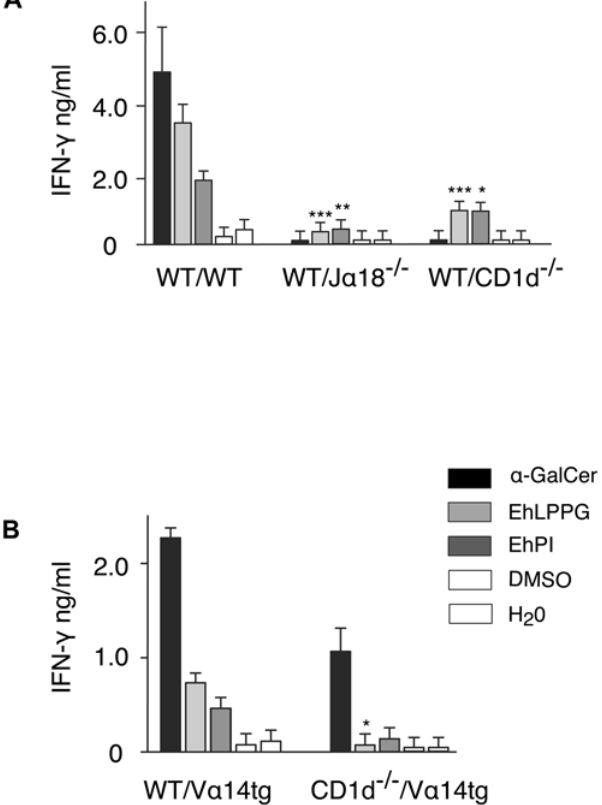
Figure 5. CD1d-restricted NKT cell activation by EhLPPG and EhPI. (A) APC (5x10 4 ) from WT mice were pulsed with either 2 m g of a - GalCer, EhLPPG or EhPI and incubated with 1x10 5 lymphocytes of spleen cell preparations from J a 18 2 / 2 lacking i NKT cells and CD1d 2 / 2 mice lacking i NKT and d NKT cells. IFN- c secretion was measured by ELISA. Difference of IFN- c production in EhLPPG/EhPI activated WT splenocytes * ( p , 0.05); ** ( p , 0.005), *** ( p , 0.001); ANOVA, Dunnett. (B) APC were generated from either WT or CD1d 2 / 2 mice, pulsed as described above and incubated with gradient purified liver lymphocytes from V a 14- transgenic mice. Liver i NKT cells were further purified by magnetic cells sorting. IFN- c was assessed by ELISA. Difference of IFN- c production in EhLPPG/EhPI activated WT splenocytes * ( p , 0.05); student t test. The results were obtained from three independent experiments.